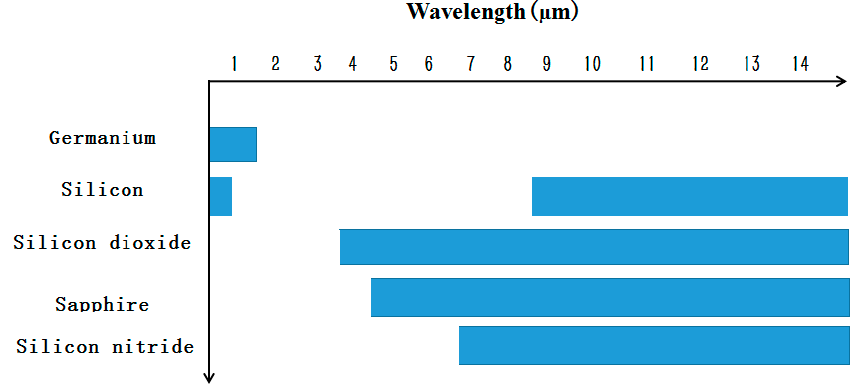
Figure 30. Light transparent window of the core materials for different waveguide and the white areas represent optical transparency meanwhile the blue areas signify high energy loss [178].